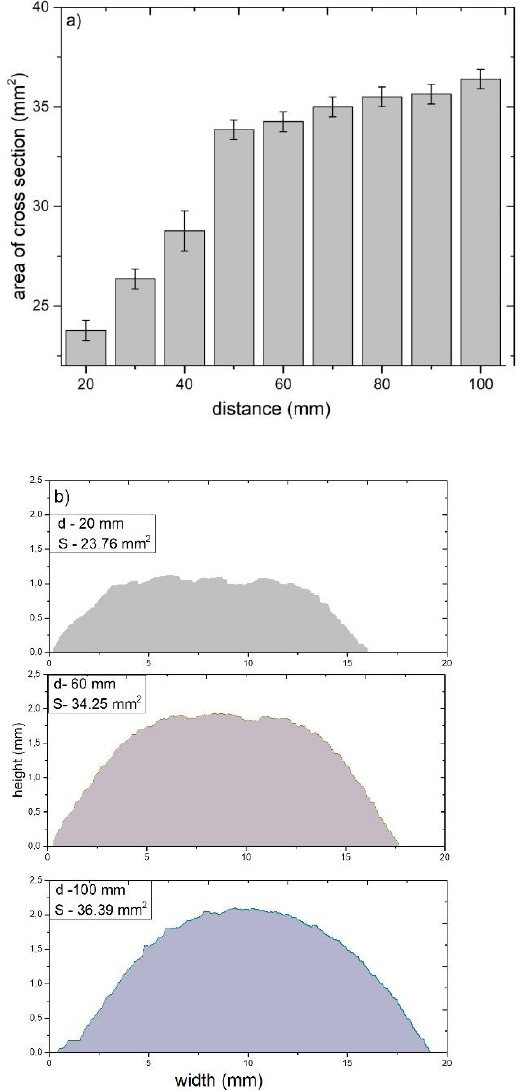
Figure 11. ( a ) Cross-sectional area versus the standoff distance (20–100 mm), ( b ) coating profiles for standoff distances of 20 mm, 60 mm and 100 mm.